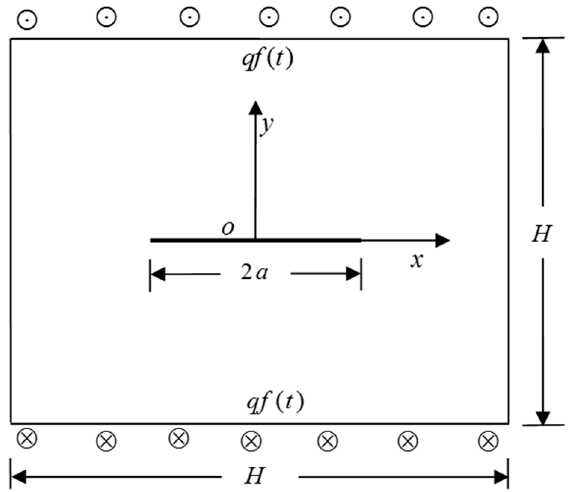
Figure 14. A schematic of a mode III crack penetrates along z -axial direction.